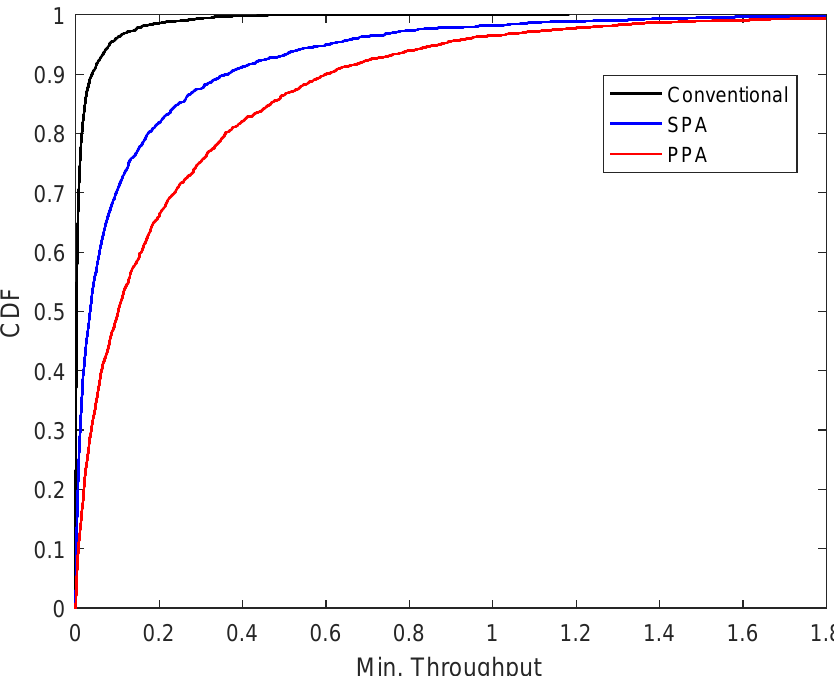
Figure 7. CDF of the minimum uplink rate per user when M = 64 using a ZF detector.